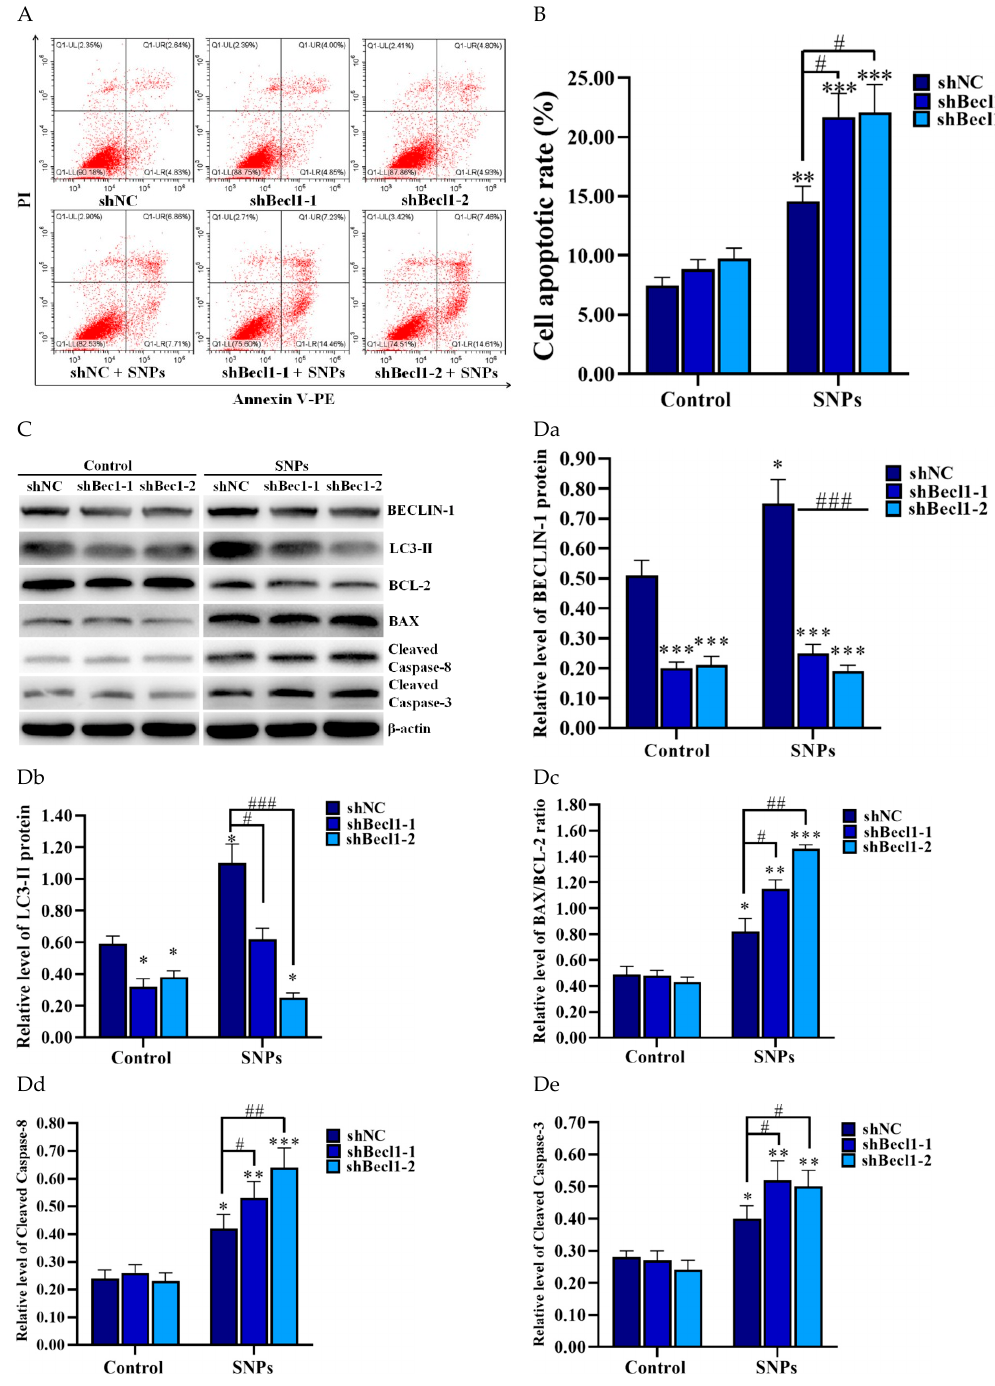
Figure 7. Effect of BECLIN-1 depletion on SNP-induced apoptosis. ( A ) The apoptotic rate was detected by flow cytometry. The PLCs were transduced with BECLIN-1 shRNA lentivirus for 48 h and then treated with 400 µ g/mL SNPs for 24 h. ( B ) Bar graphs of the statistical analysis of the apoptotic rate in ( A ). ( C ) Autophagy and apoptosis-related proteins were detected by Western blotting. The PLCs were transduced with BECLIN-1 shRNA lentivirus for 48 h and then treated with 400 µ g/mL SNPs for 12 h. ( D ) Bar graphs of the protein band intensity in ( C ) were analyzed as the relative ratio of BECLIN-1 ( Da ), LC3-II ( Db ), the BAX/BCL-2 ratio ( Dc ), cleaved caspase 8 ( Dd ), and cleaved caspase 3 ( De ), respectively, to β -actin. Note: * p < 0.05, ** p < 0.01, and *** p < 0.001 compared to the shNC group; # p < 0.05, ## p < 0.01, and ### p < 0.001 compared to the shNC + SNP